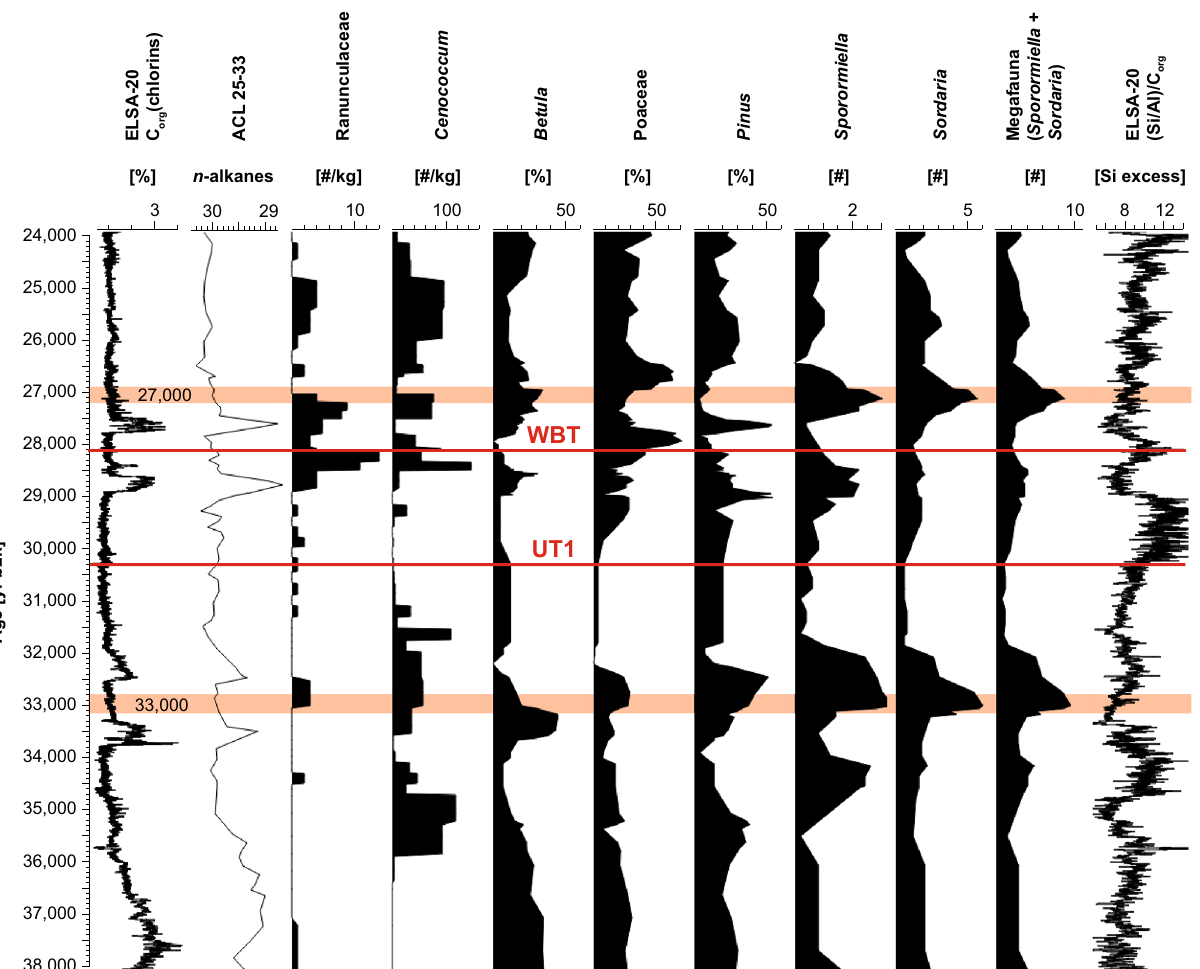
Figure 5. Selected pollen, botanical macroremains, and spores from 38,000 to 24,000 yr b2k. The plots are based on those samples with more than 20 countable pollen grains. The curves are smoothed with a five-point running mean. Values for all taxa counted see Supplementary Figs. S8, S9. Brownish bars indicate the times of high Megafauna